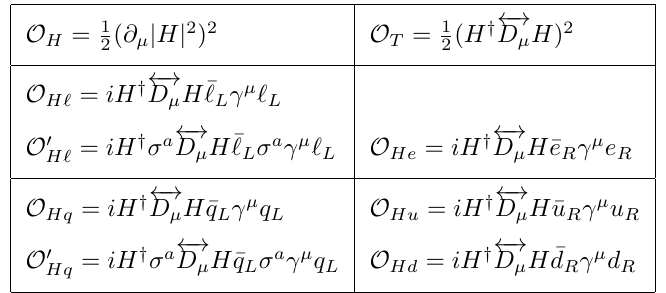
Table 2 . The dimension-6 operators related to Higgs-Higgs and Higgs-fermion sum